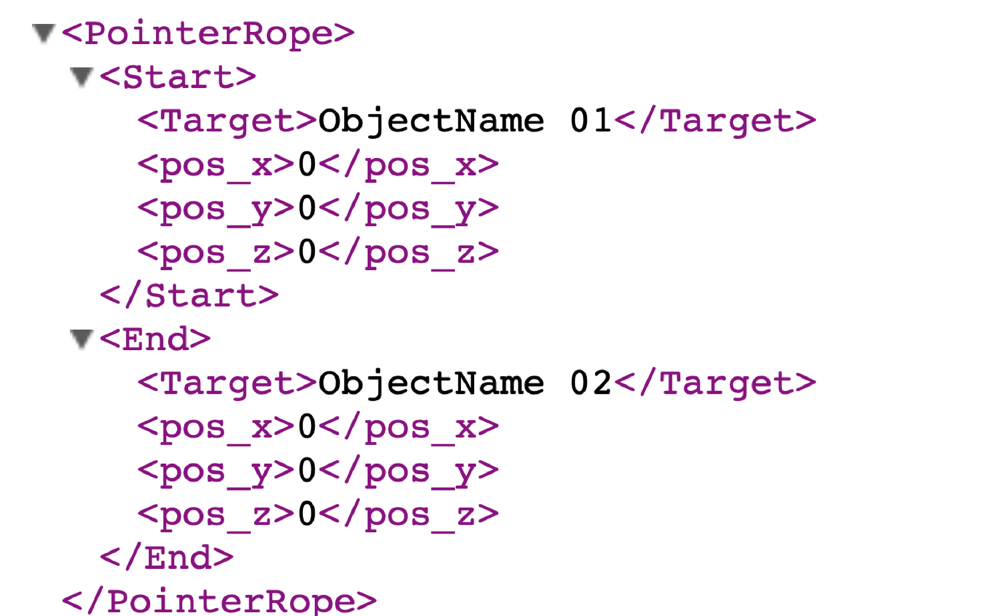
Figure 22. Description example of PointerRope element.